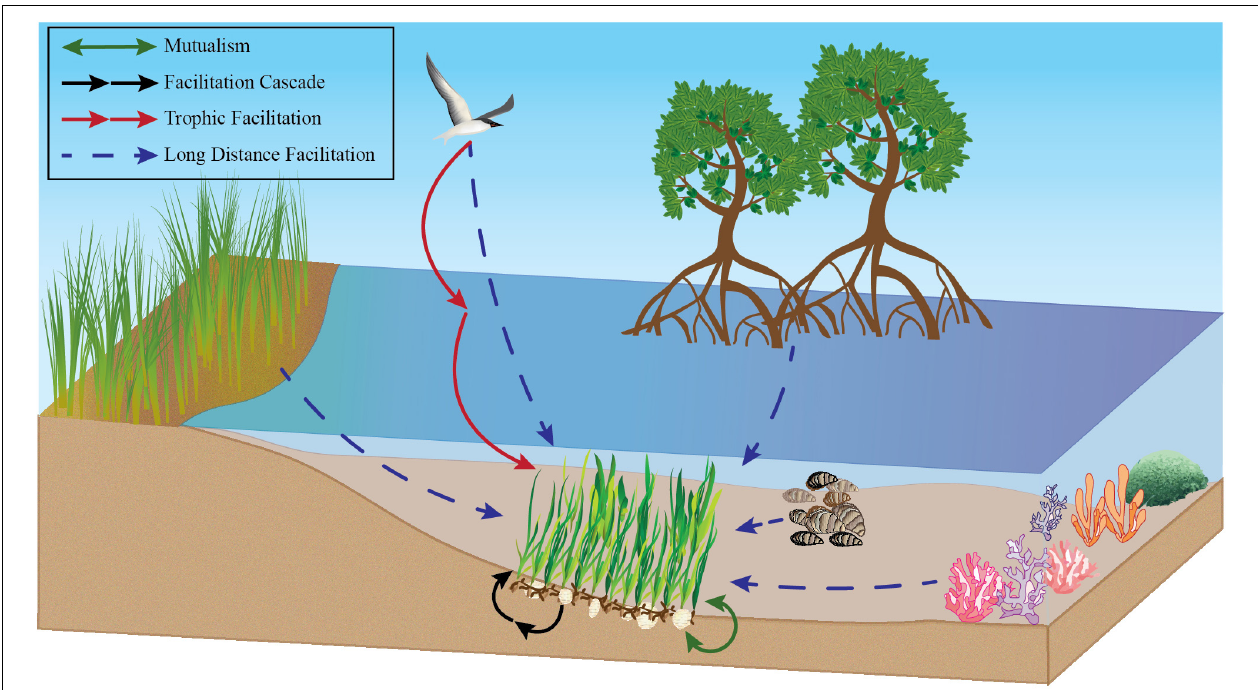
FIGURE 1 | Conceptual drawing of many positive interactions impacting seagrass. This includes but is not limited to long distance facilitation with corals, oysters, mangroves, seabirds, and salt marshes, mutualisms between seagrass and lucinid clams, and facilitation cascades of bivalves in seagrasses as examples.